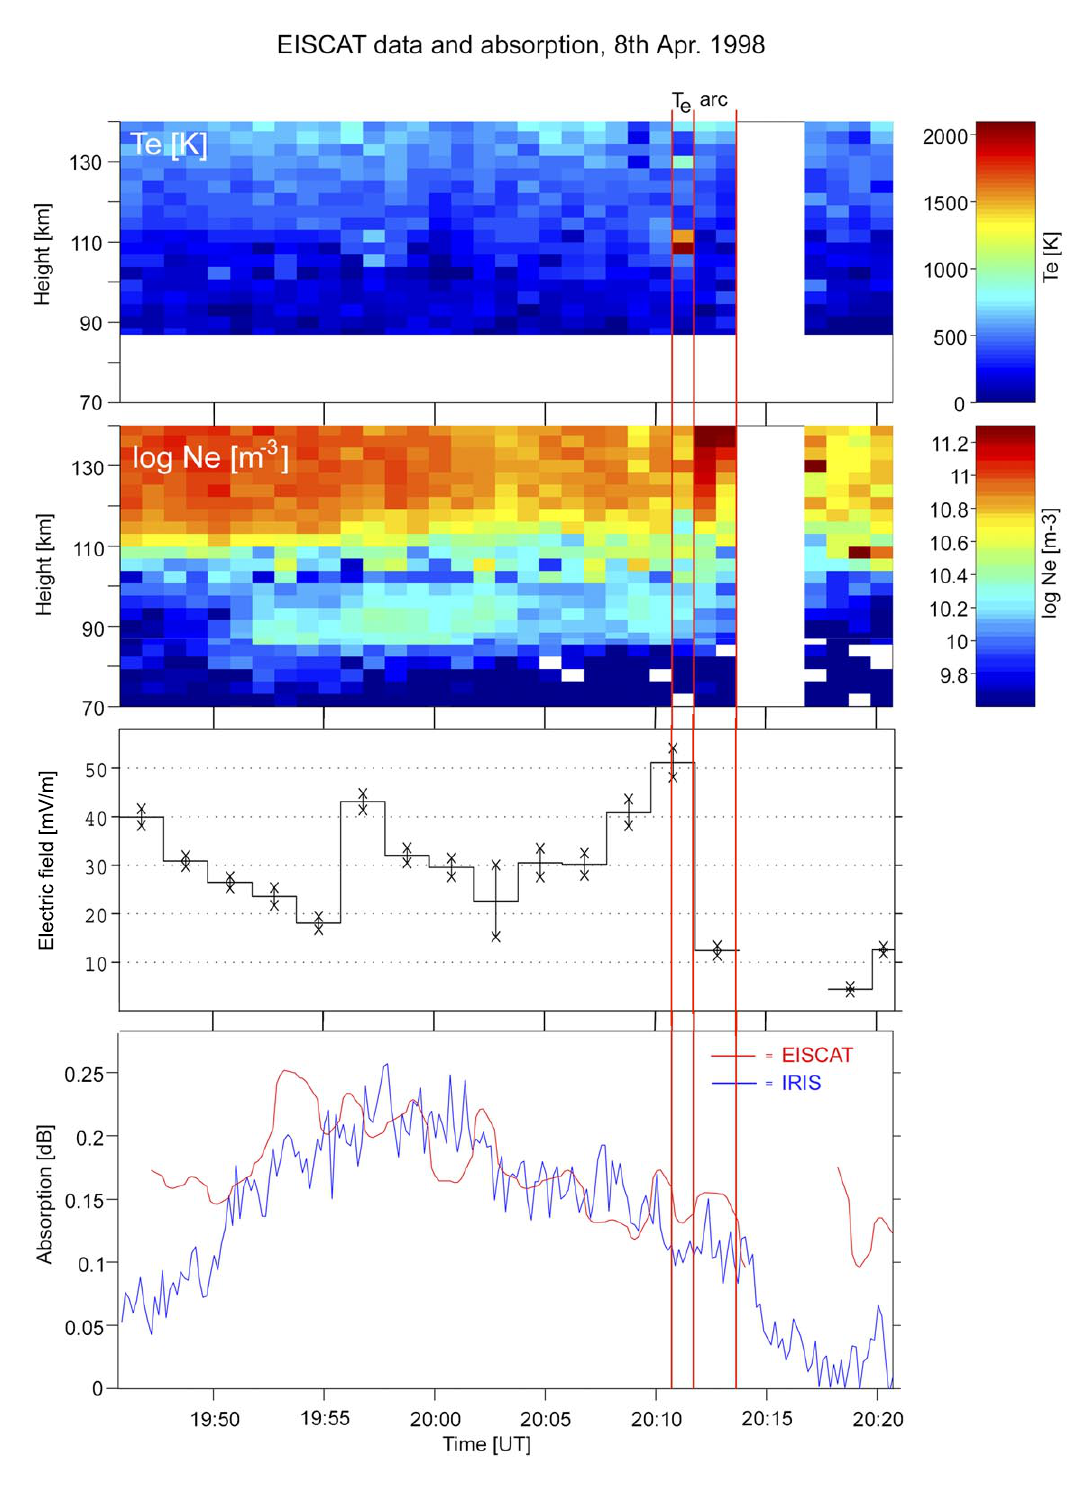
Fig. 6. The EISCAT data for the Event 2, with an integration time of 60s for T e and N e , and 120s for the electric field. The data format is the same as in Fig. 3. The panels from top to bottom are electron temperature, electron density, total intensity of electric field and absorption, both from IRIS and